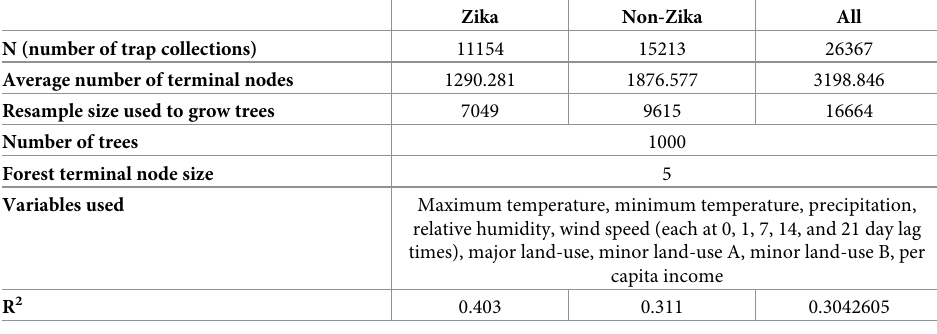
Table 3. Details of random forest models. Models were trained on data of adult female Ae . aegypti counts from traps in areas affected by local transmission during the 2016 Zika outbreak, traps in unaffected regions, and all traps. Zika Non-Zika All N (number of trap